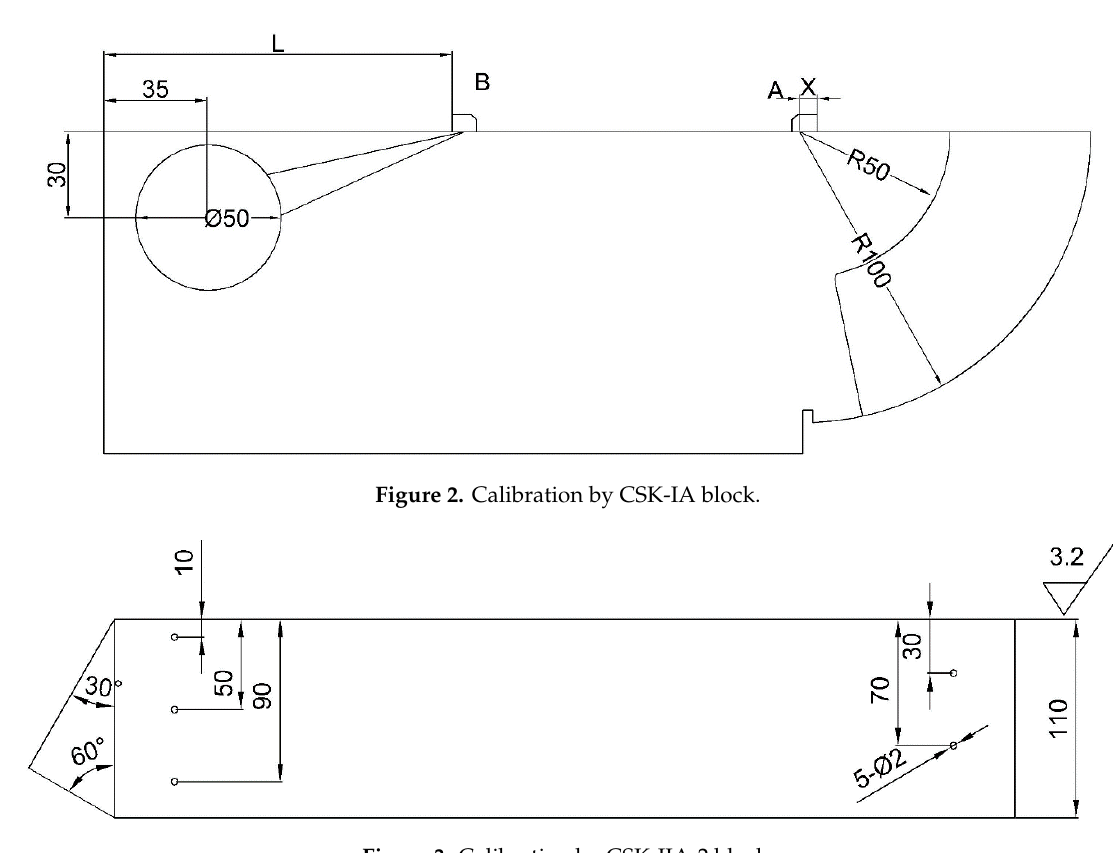
Figure 3. Calibration by CSK ‐ IIA ‐ 2 block.